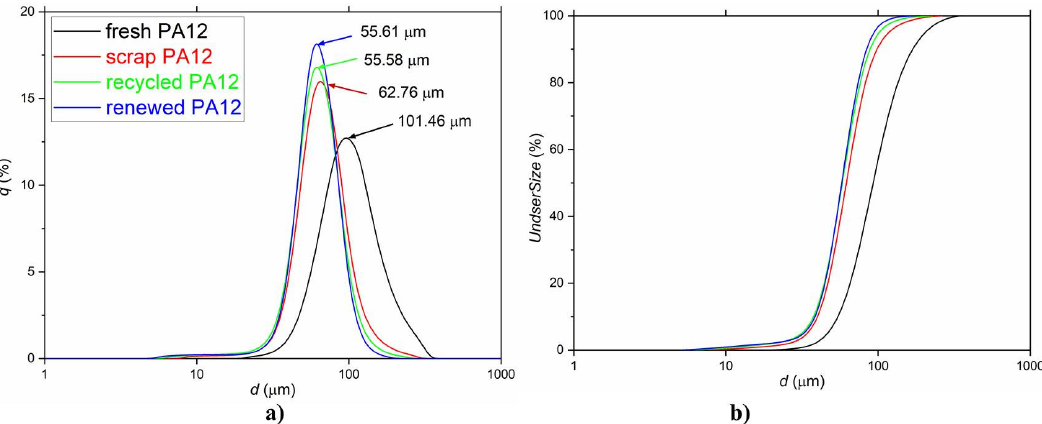
Figure 2. Log-normal ( a ) and cumulative ( b ) particles size distribution (PSD) of experimental samples. The mode diameter (dm) values are noted in the graph. Table 1. Particle size (d 43 , d 10 , and d 90 ) and specific surface area (SSA BET , SSAcal) of experimen- tal